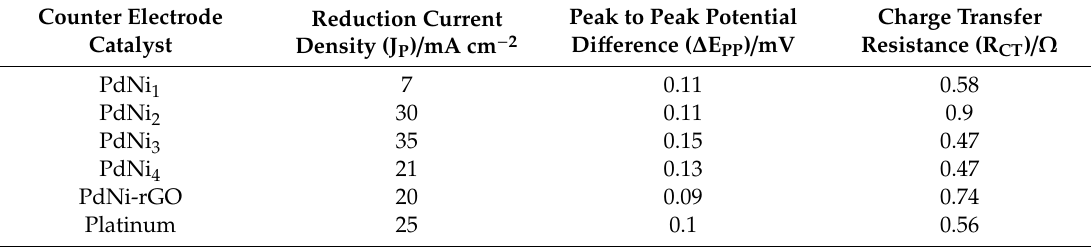
Table 2. Electrochemical parameters for the synthesized counter electrode samples.